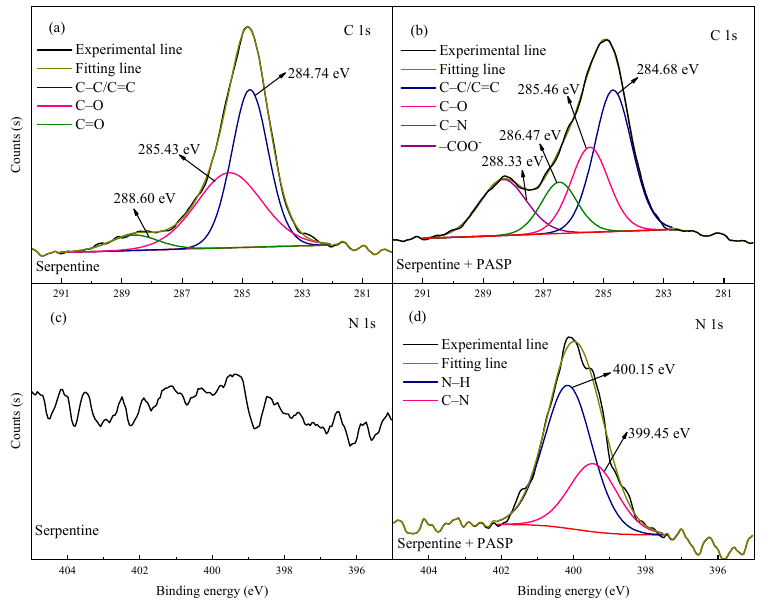
Figure 8. High-resolution spectra of ( a , b ) C 1s, and ( c , d ) N 1s of serpentine before and after the pretreatment of PASP (pH = 9).